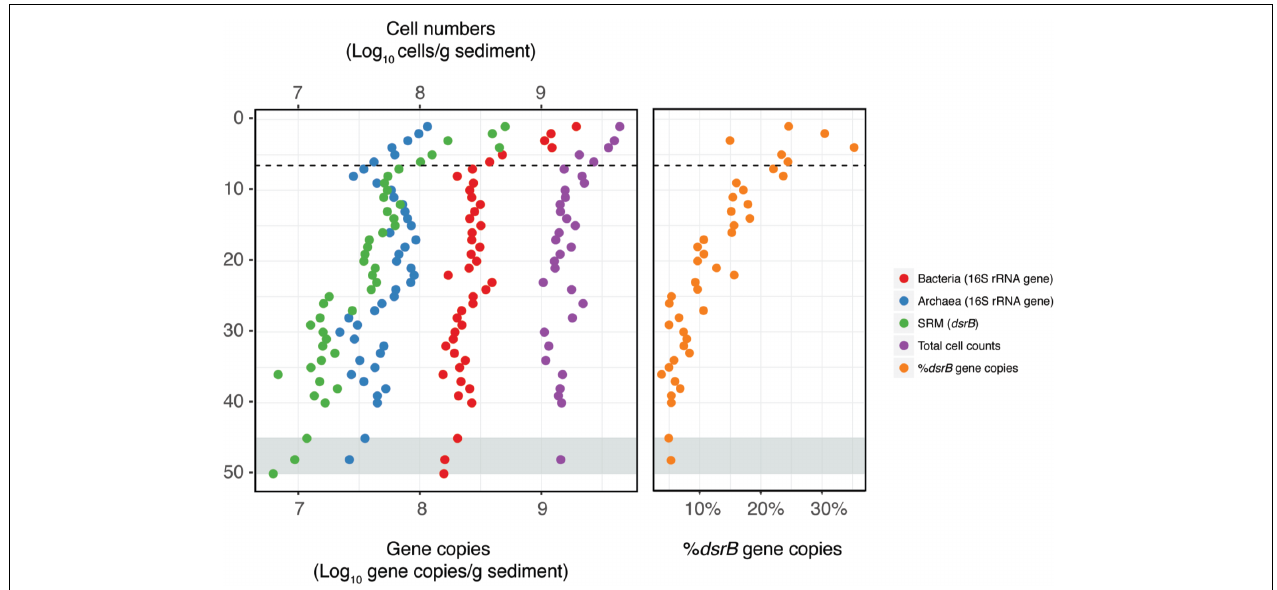
FIGURE 2 | Distribution of microbial abundances with depth. Bacterial, archaeal, and sulfate reducing microorganisms (SRM) were quantified by qPCR. Total cell counts (TCC) were quantified by direct epifluorescence microscopy of microbial cells. The dashed line indicates the depth of the bottom of the bioturbation zone and the gray shading indicates the onset of the